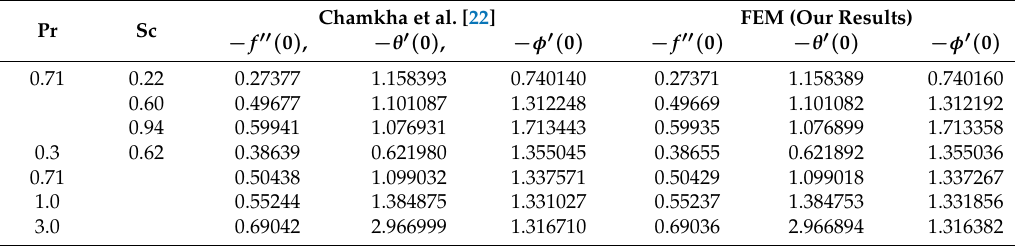
Table 6. Comparison of − f (cid:48)(cid:48) ( 0 ) , − θ (cid:48) ( 0 ) , and − φ (cid:48) ( 0 ) for various values of Pr and Sc ( M = σ = λ 3